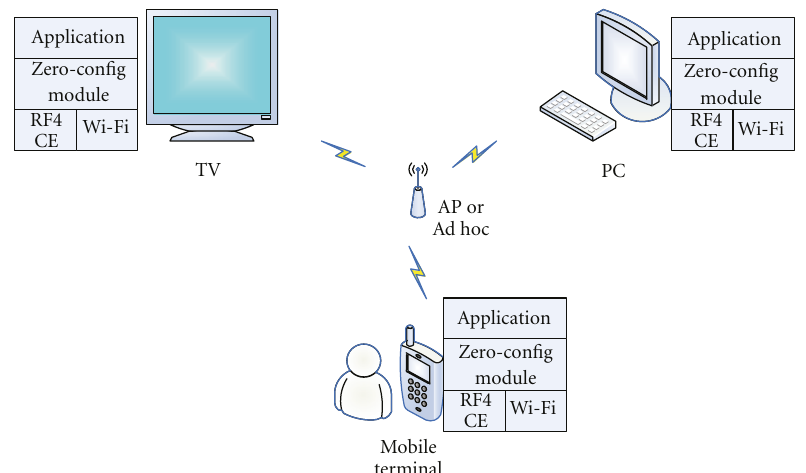
Figure 2: Overall environment of zero configuration